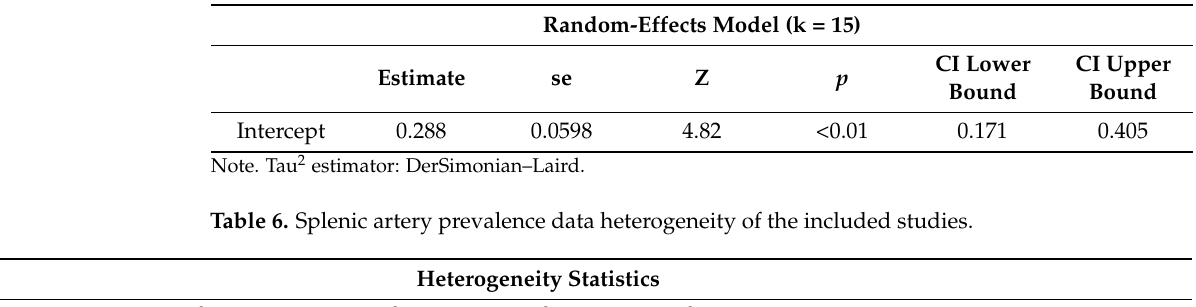
Table 5. Splenic artery prevalence data of the included studies.